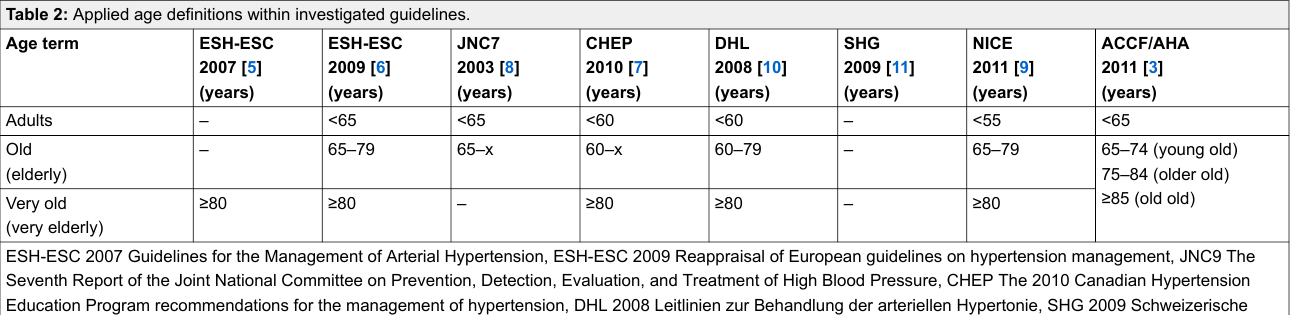
Table 2: Applied age definitions within investigated